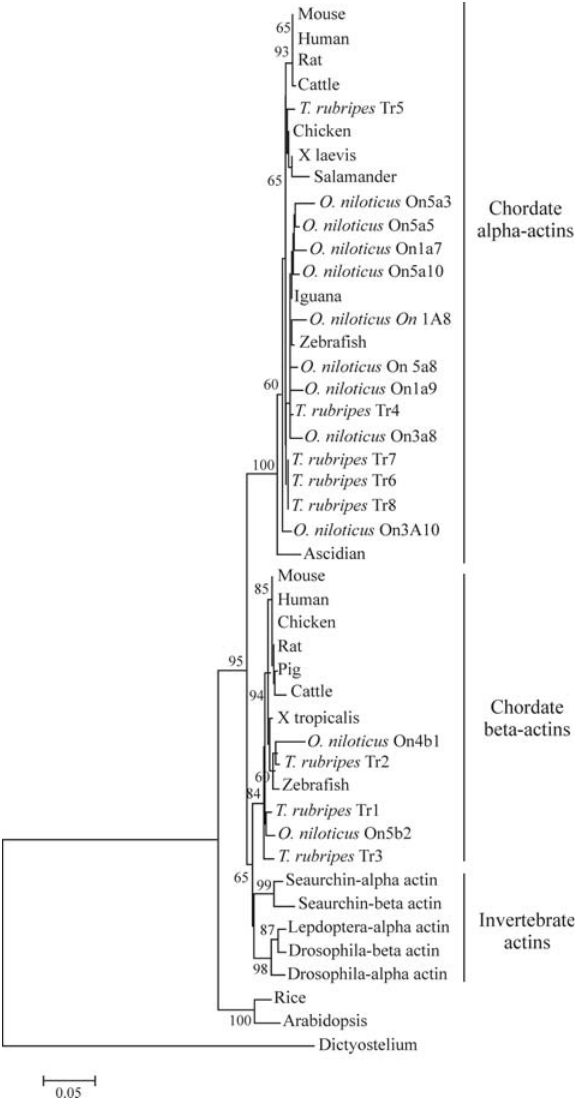
Figure 2 - Molecular phylogenetic tree inferred by the neighbor-joining method from predicted amino acid (aa) sequences of actin genes. The myxamoeba species Dictyostelium discoideum was used as an outgroup. Branch lengths are proportional to evolutionary distances. Scale bar indi- cates an evolutionary distance of 0.05 aa substituition per position in the sequences. The numbers at each node indicate the percentage recovery (> 60%) of the particular node (500 bootstrap replicates) in which the same internal branch was recovered. Sources and accession numbers for the actin sequences are described in Material and Methods.